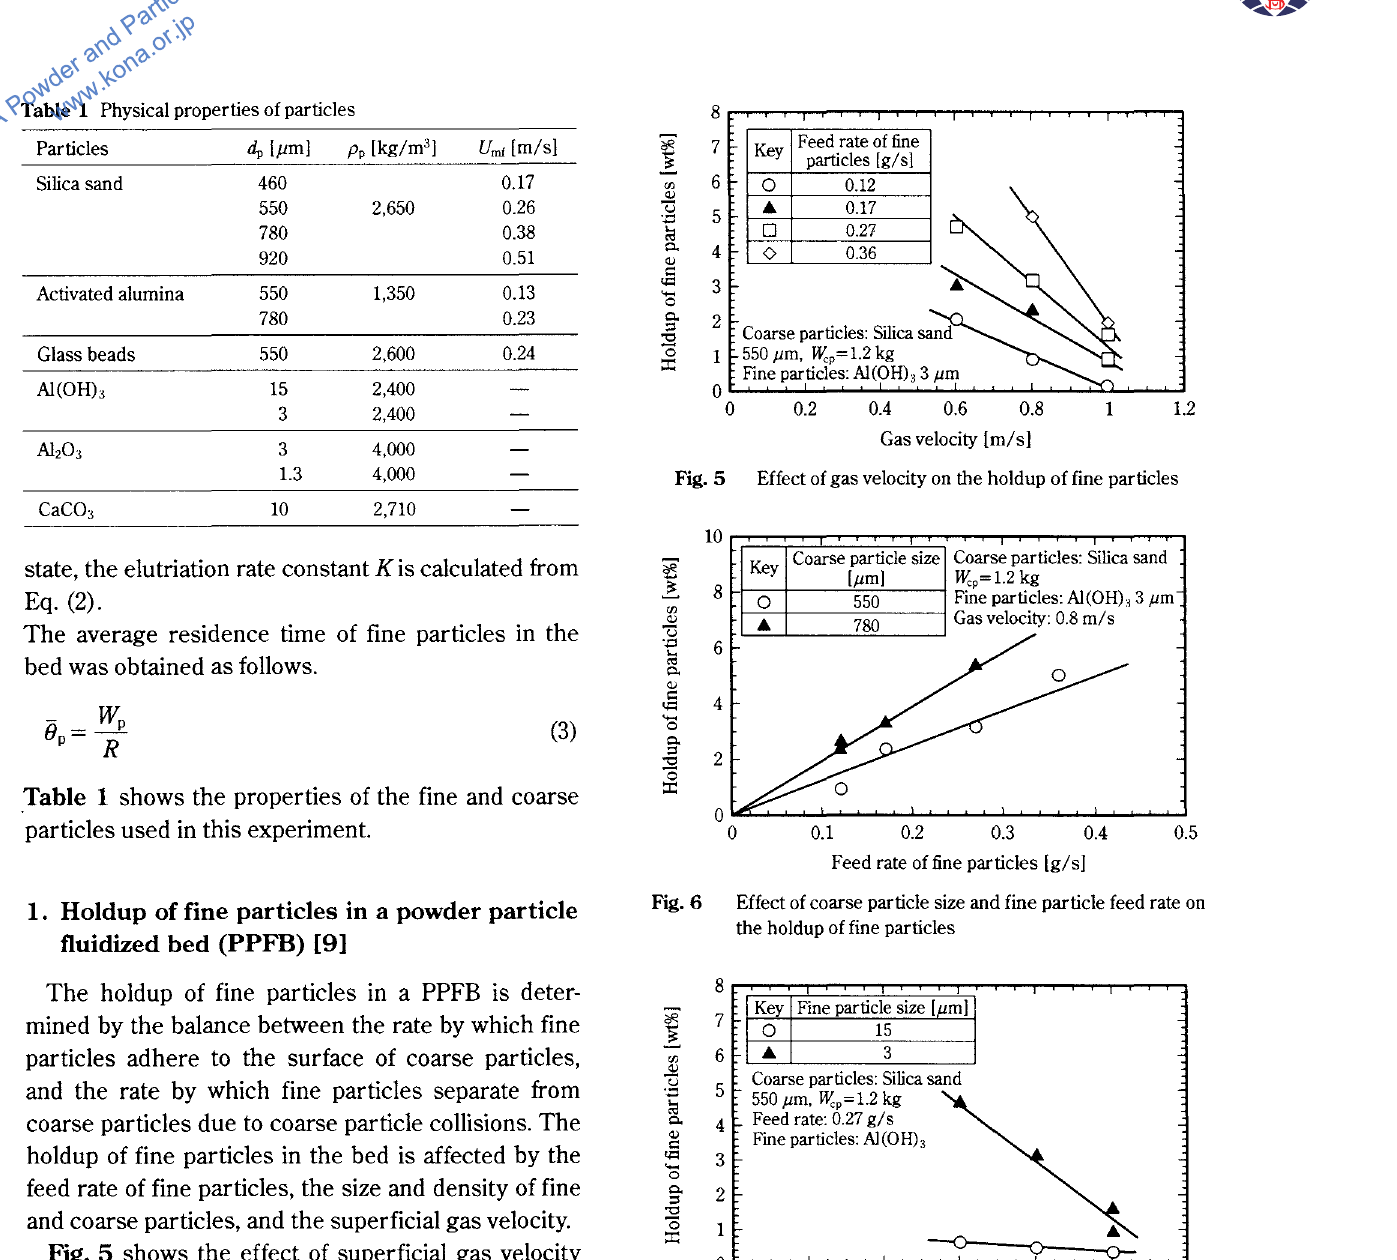
Fig. 7 Relationship between fine particle diameter and gas velocity on the holdup of fine particles